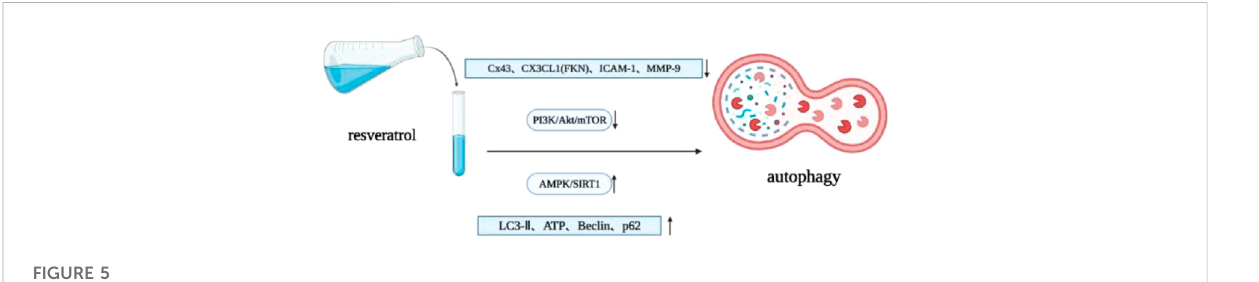
FIGURE 5 Resveratrol regulates